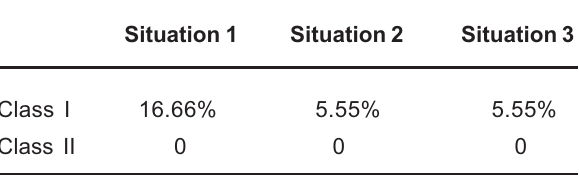
TABLE 1- Prevalence indices individually separated according to type of RPD